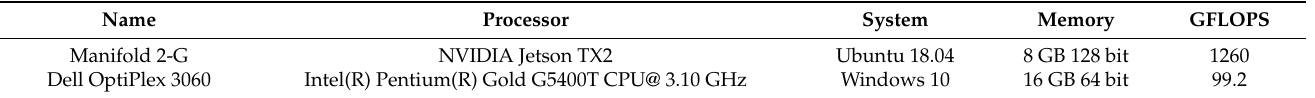
Table 1. Configuration parameters for the robot controller. (The robot controller is the CPU of the robot and provides various interfaces to connect different external devices and handle the asso- ciated computing